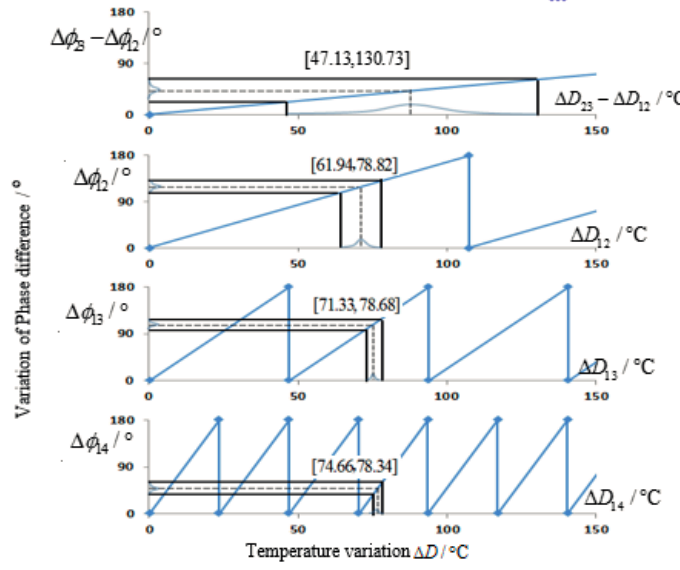
Figure 7. Determination process of temperature